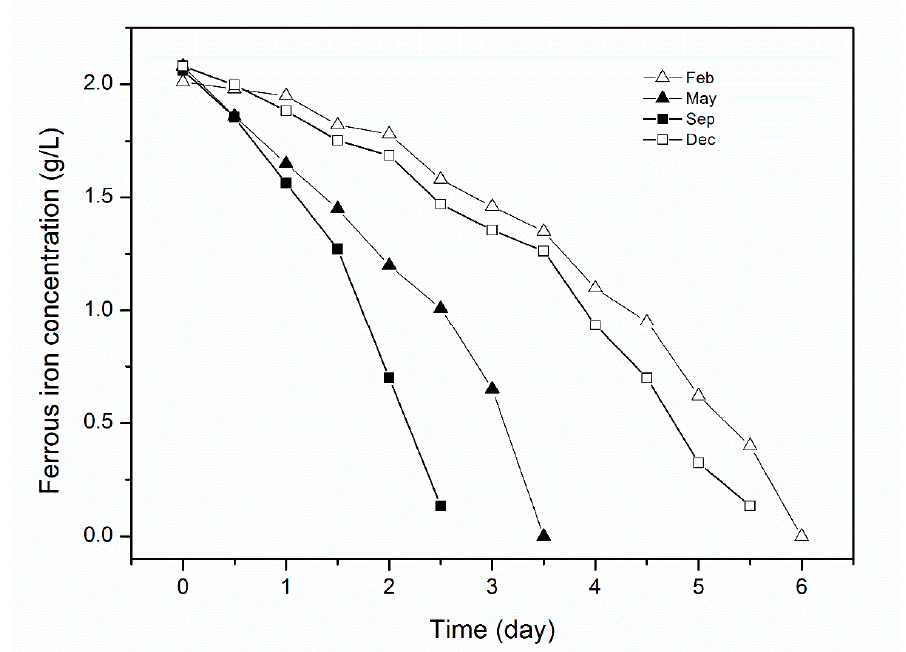
Figure 6. Ferrous iron oxidation activity of the microbes from the leachate of P3C6 collected at different time during heap bioleaching.